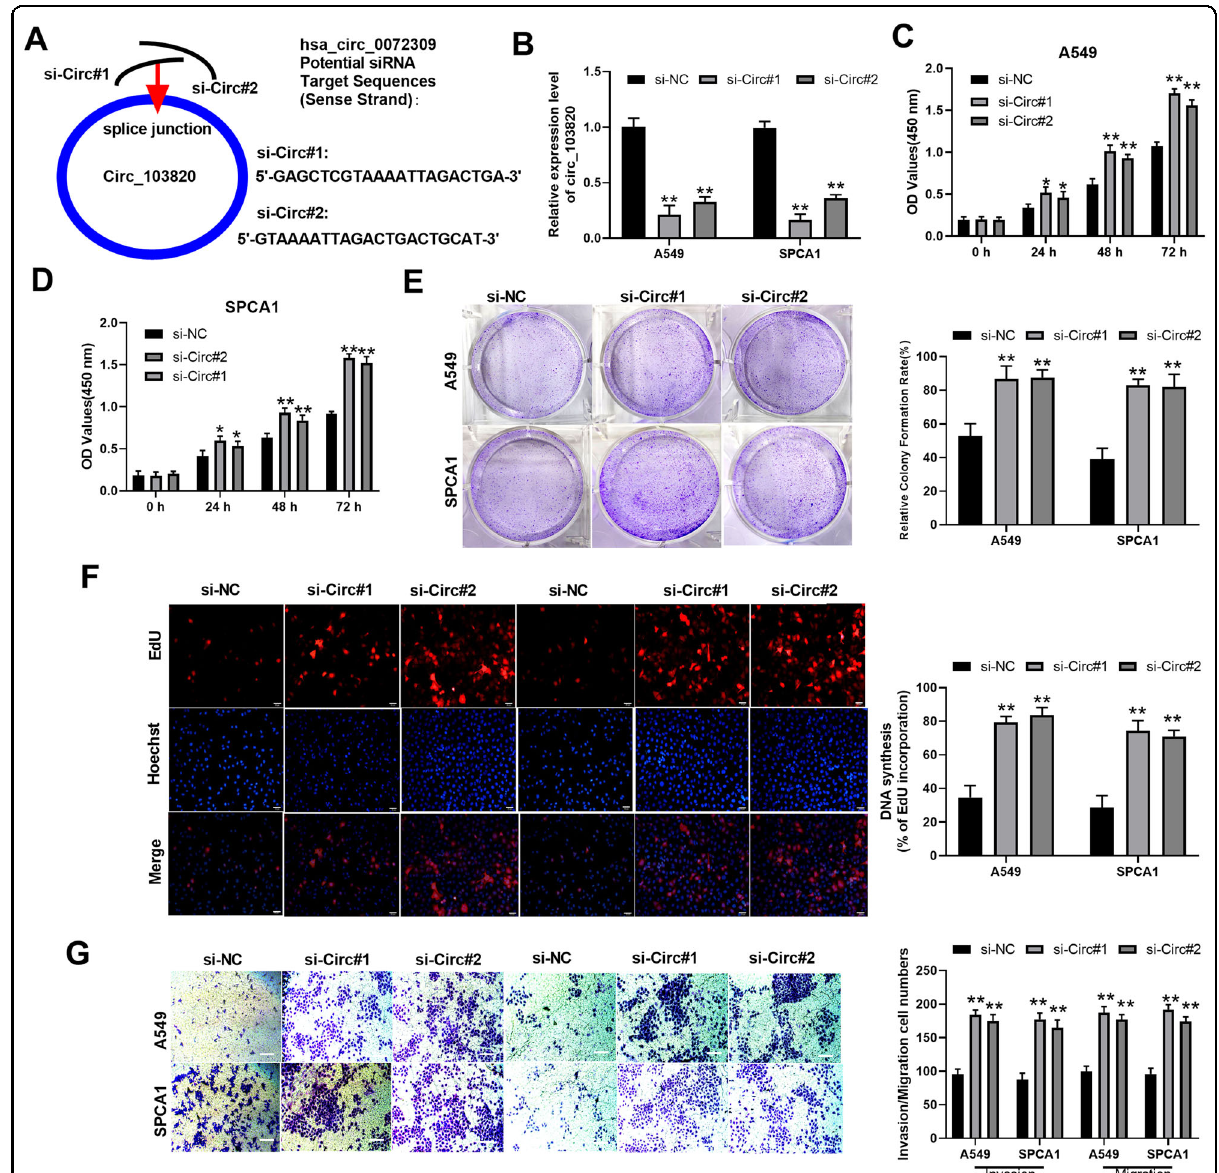
Fig. 4 Knockdown of hsa_circ_103820 promoted the proliferation, migration, and invasion of lung cancer cells. A The sequences of hsa_circ_103820-targeting siRNAs were designed based on the splice junction. B Hsa_circ_103820 siRNAs were transfected into A549 and SPCA1 cells, and the transfection effect was determined using qRT-PCR assay. The impacts of hsa_circ_103820 knockdown on cell proliferation were checked by using CCK-8 ( C, D ), colony formation ( E ) and EdU staining assays ( F ) in A549 and SPCA1 cells. G The in fl uences of hsa_circ_103820 knockdown on cell migration and invasion were assessed with Transwell assays. Scale bars, 100 μ m. Data are mean ± SD, n = 3. * P < 0.05, ** P < 0.01 (Student ’ s t